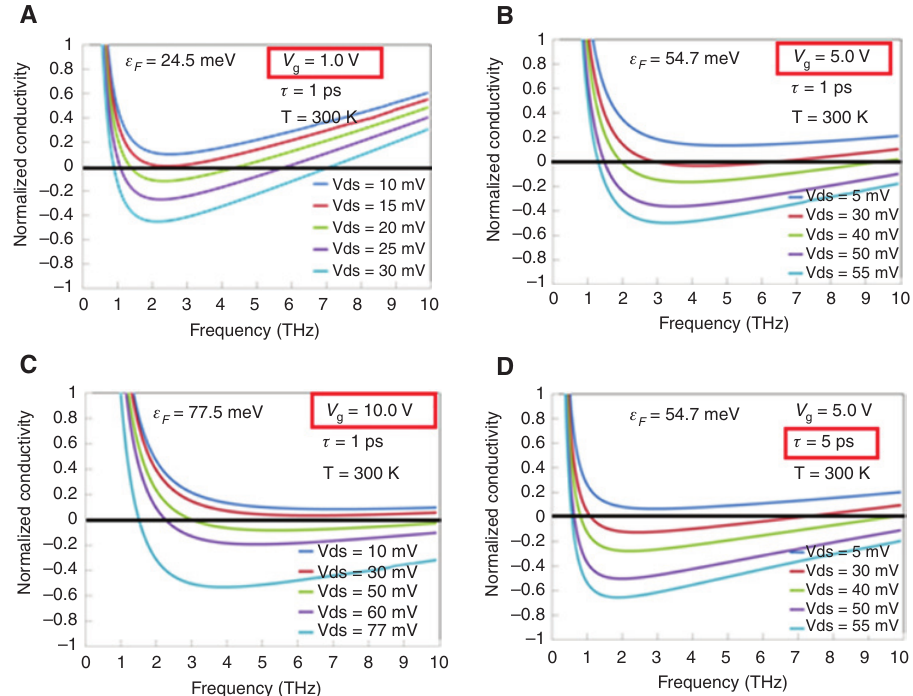
Figure 3: Real part of the conductivity spectra of a complementary dual-gate-biased DG-GFET at 300 K for different drain-source bias